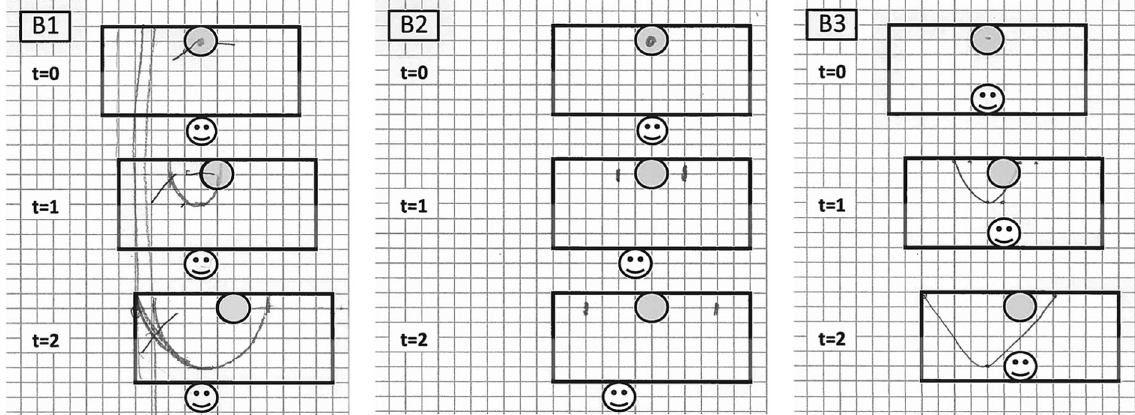
FIG. 6. EDs of participants who drew uniform light propagation relative to the graph paper. The position of the light flash changes each time step with two squares relative to the position on the paper the light flash had in the previous time unit. The ED in the middle shows that the participant only indicated the position of the wave front in the horizontal direction. The other participants drew wave fronts.